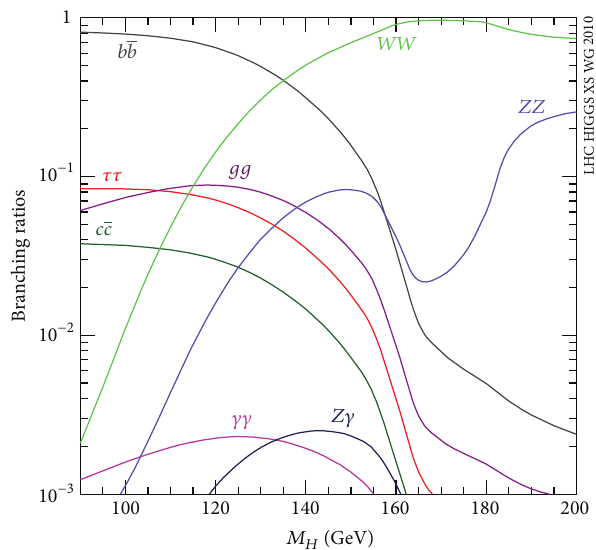
Figure 18: Higgs boson branching ratios in the SM at the LO from